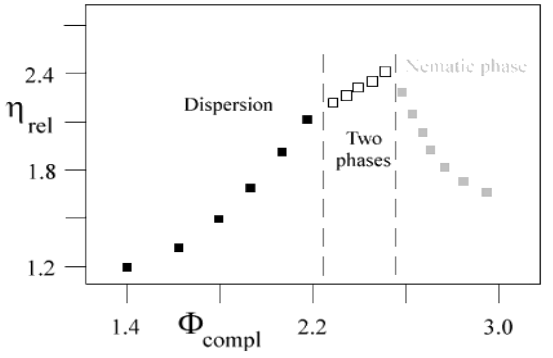
Figure 6. Normalized zero shear viscosity, η rel , vs. the volume fraction of the complex, Φ compl , in percent units. Data refer to 1/1 mixtures of ss-DNA/CNT complexes, at 25.0 °C. Vertical lines indicate the phase boundaries.